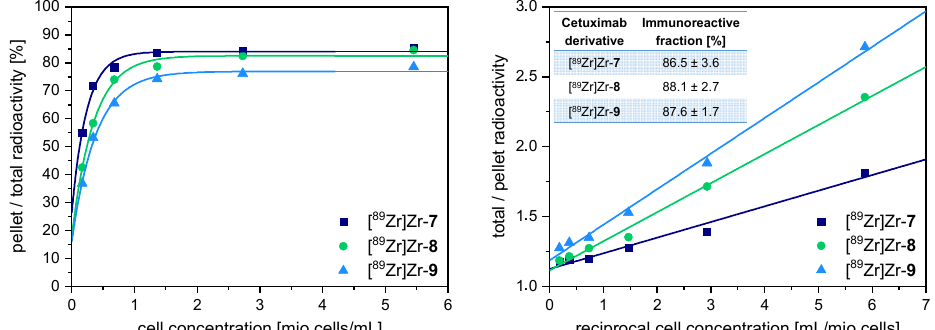
Figure 5. Results of the determination of the immunoreactive fraction of [ 89 Zr]Zr- 7 –[ 89 Zr]Zr- 9 on A431 cells. Shown are exemplary Lindmo plots as obtained during each individual experiment; immunoreactive fractions were obtained from three independent experiments, each performed in